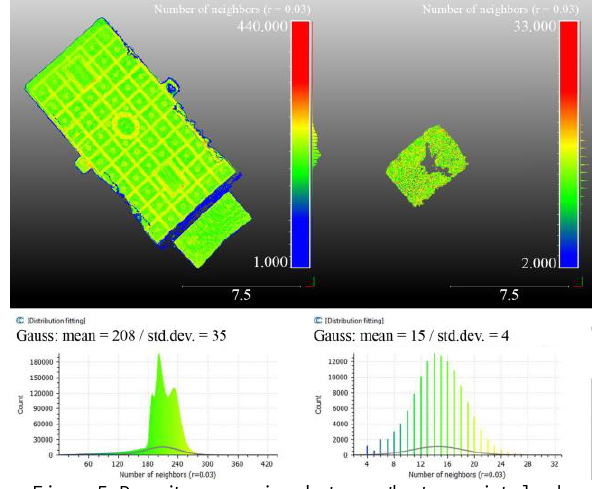
Figure 5. Density comparison between the two point clouds (number of neighbours analysis, pts/V sphere r = 0.03 m).